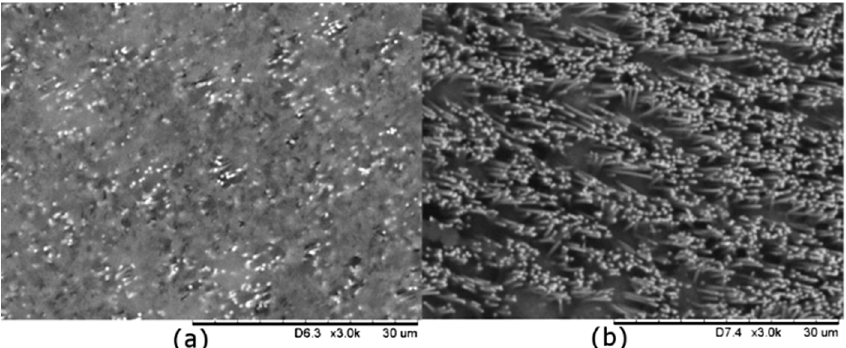
Figure 1. Scanning electron microscopy ( SEM) images of CuWNEEs obtained by ( a ) template deposition after chemical etching; and ( b ) after low temperature plasma etching of CuWNEE reported in ( a ).